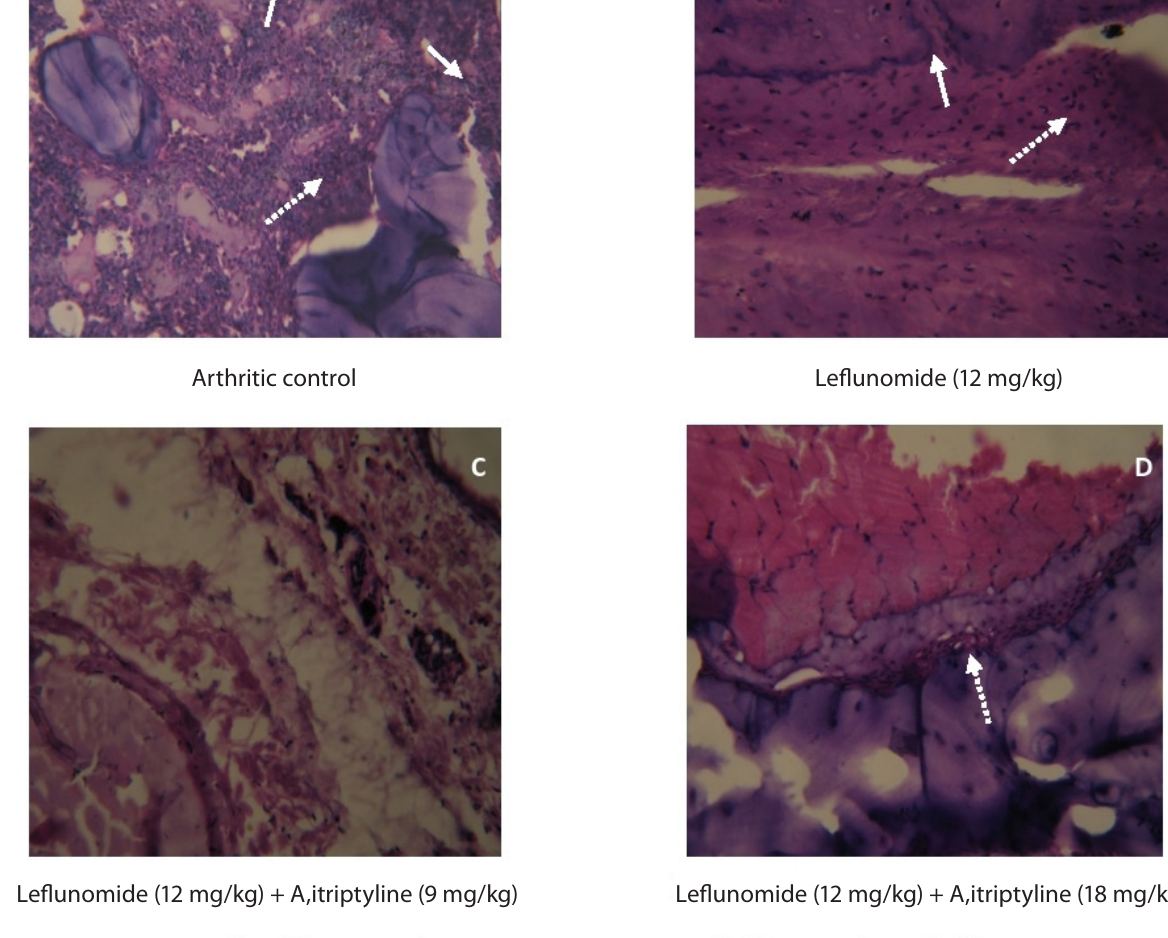
FIGURE 2 - Histopathological changes in joints of FCA induced rats (H & E, X